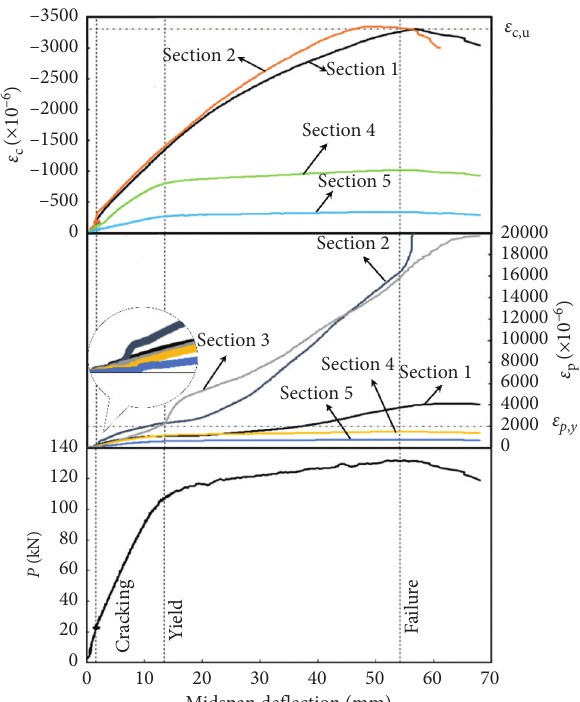
Figure 16: Load ( P ) and the longitudinal strain of concrete ( ε